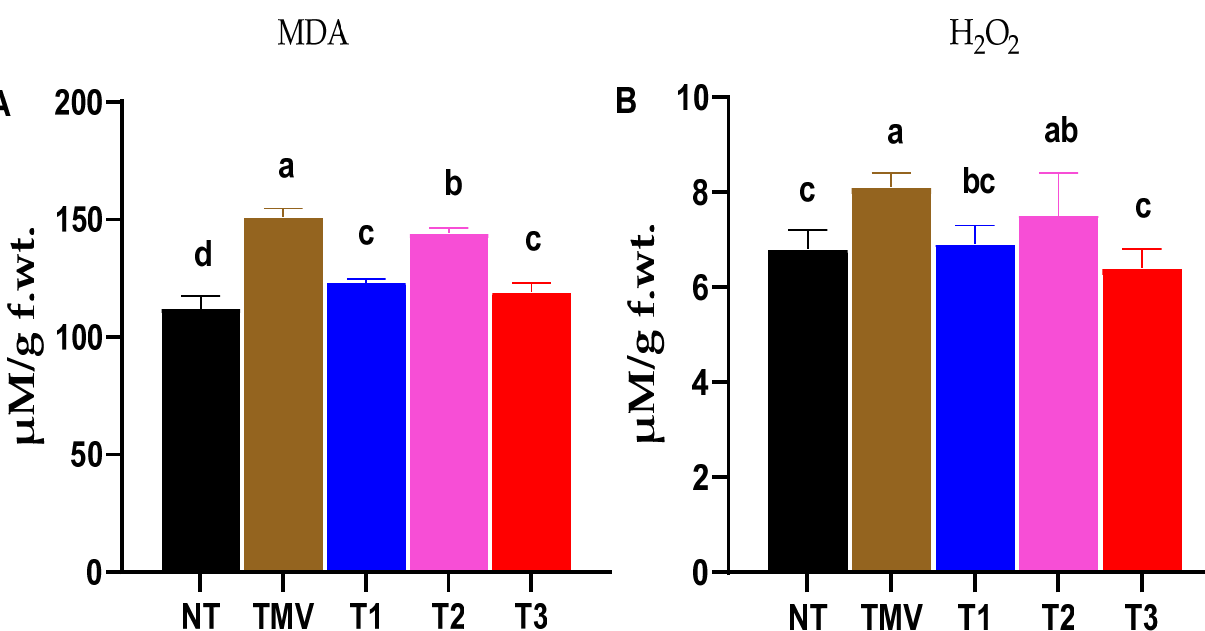
Figure 3. Effect of foliar application of B. subtilis strain HA1-culture filtrate on the two oxidative stress markers: MDA ( A ) and H 2 O 2 ( B ) of tomato plants at 22 days post-TMV inoculation. NT: mock plants; TMV: virus-infected plants; T1: tomato plants sprayed with bacterial culture filtrate 24 h before viral infection; T2: tomato plants sprayed with bacterial culture filtrate 24 h after viral infec- tion; T3: tomato plants sprayed with bacterial culture filtrate two times, 24 h before and 24 h after viral inoculation. Each column value represents the mean result obtained from five biological repli- cates. Significant differences were calculated using a one-way ANOVA according to the least significant difference (LSD) method at a p ≤ 0.05 level of probability with the GraphPad Prism software package. The mean values of each column with the same letter do not differ significantly.